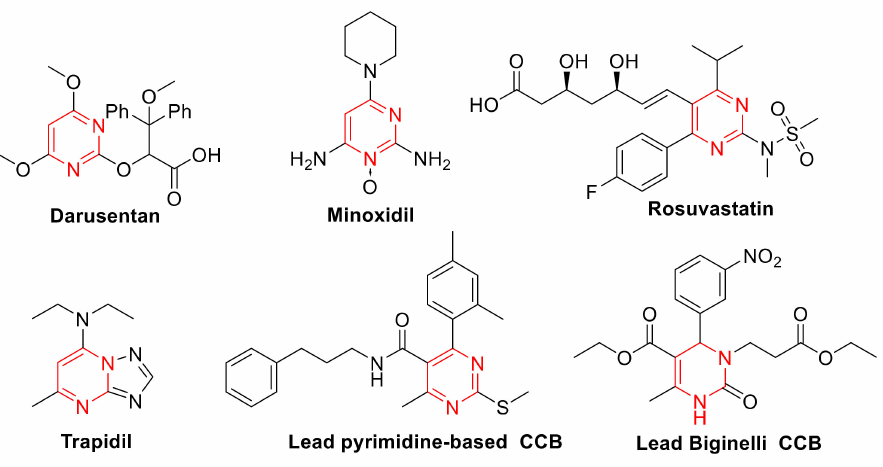
Figure 1. Pyrimidine-derived cardiovascular